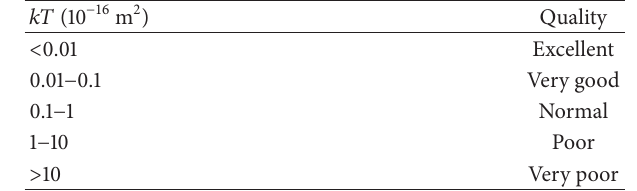
Table 2: Quality of permeable concrete surface